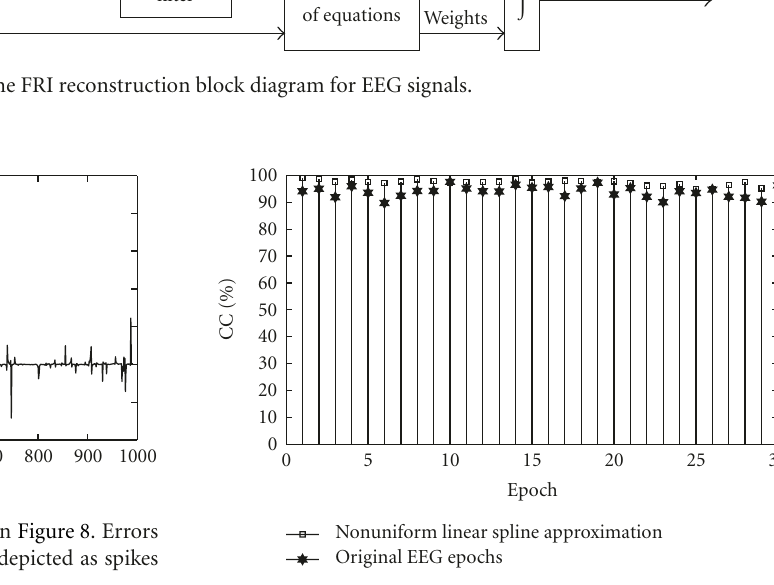
Figure 9: Comparison of the 30 epochs’ CC in the event of (i) sampling the original EEG epochs and (ii) sampling